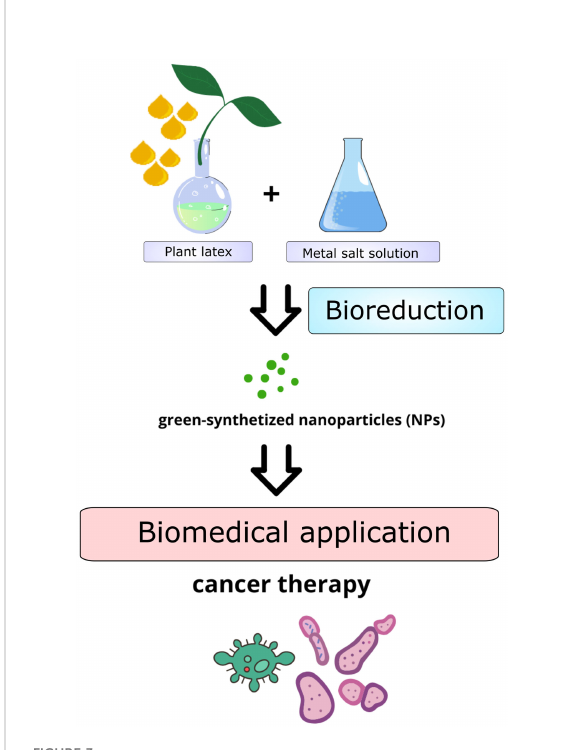
FIGURE 3 Schematic overview of the preparation of green-synthetized nanoparticles (NPs) using plant